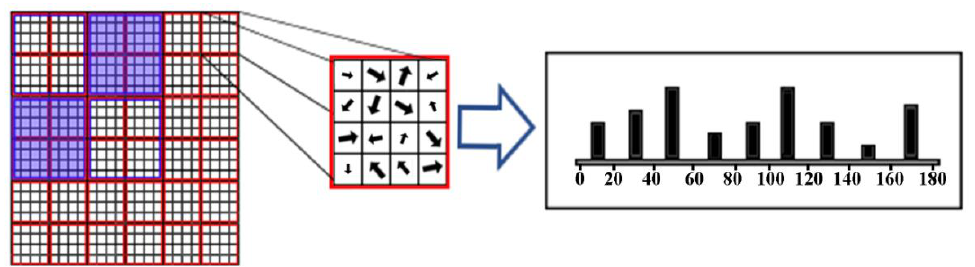
Figure 3. Visualization of cells (4 by 4 pixels) and blocks (each containing 4 cells) in the HOG algorithm.